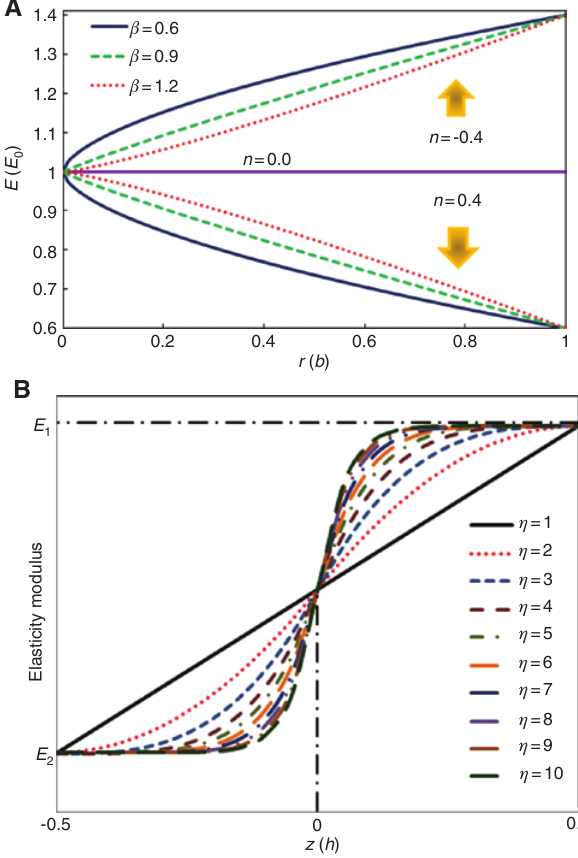
Figure 2: Variations in material properties for (A) the radial and (B) the axial FGBM configurations.